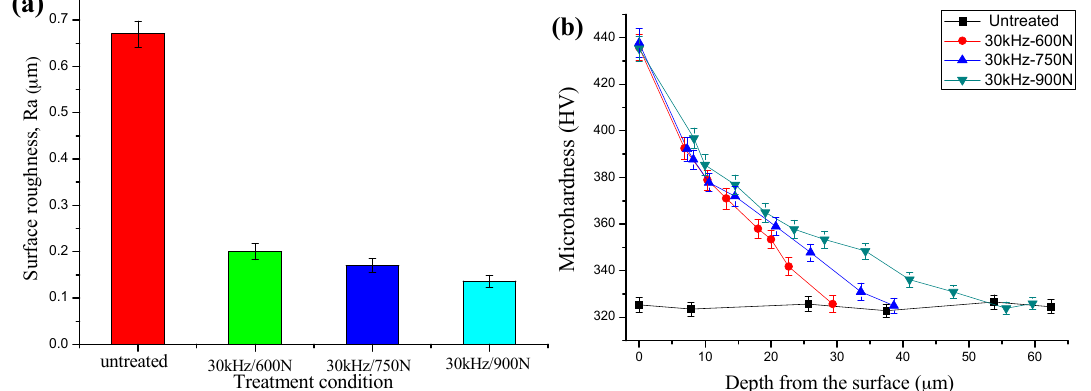
Figure 7. ( a ) Surface roughness values of the different conditions treated samples; ( b ) variation in microhardness of samples treated by MUSR along the depth direction from the treated surface.